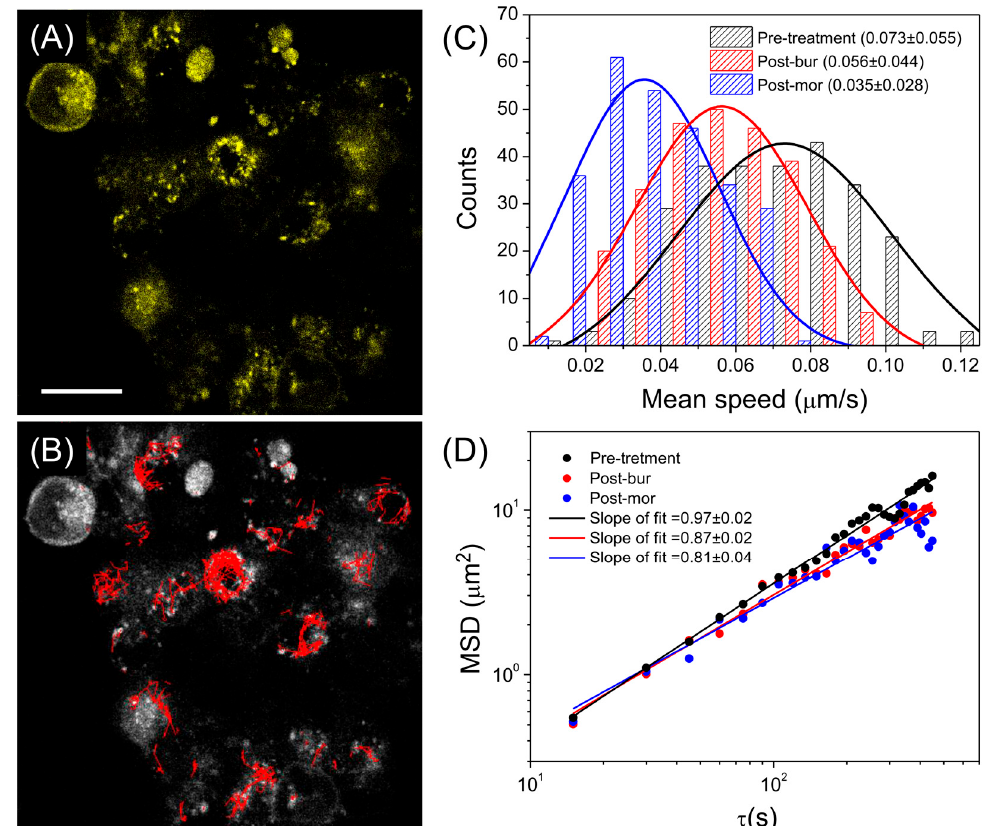
Figure 2. ( A , B ) are 2D images taken from the NOP-YFP channel treated with morphine, with ( B ) showing the trajectories of mobilized heterodimers. Scale bar = 20 µ m. ( C ) is the histogram of mean speed for the three conditions, which were fitted to Gaussian distributions showing the mean speed with maximum probability and a standard deviation. ( D ) presents the extraction of the exponent and diffusion coefficient in the three conditions from linear fitting to the log-log plot of MSD with respect to lag times. To provide a clear interpretation of MSD data, standard deviations are not shown. Twenty-four trajectories were used for statistics in each condition.